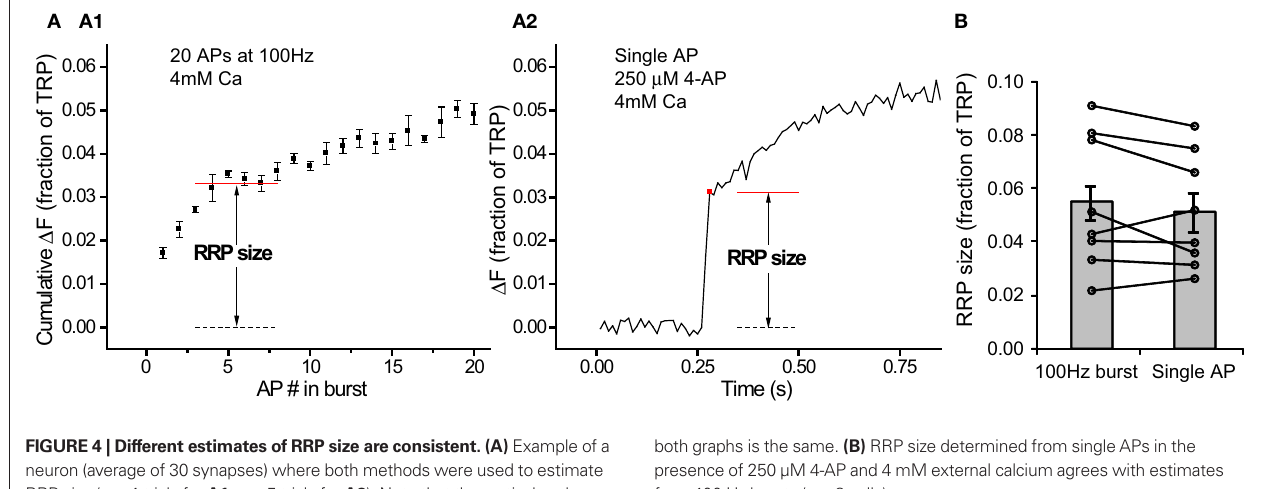
Figure 4 | Different estimates of rrP size are consistent. (A) Example of a neuron (average of 30 synapses) where both methods were used to estimate RRP size ( n = 4 trials for A1 , n = 5 trials for A2 ). Note that the vertical scale on